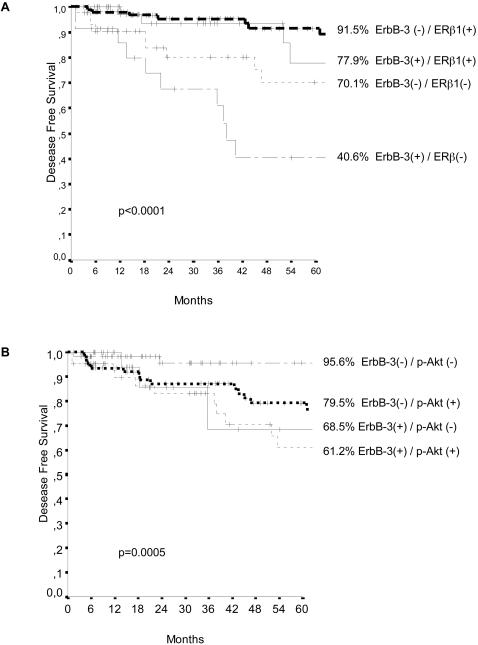
DFS (232 cases) for TAM treated patients with breast carcinomas categorised according to the combinations in all evaluated cases of (A) ErbB-3 and ERβ1 expression, (B) ErbB-3 and P-Akt expression.Survival curves were generated according to the Kaplan-Meier method; statistical comparisons were made using the log-rank test.